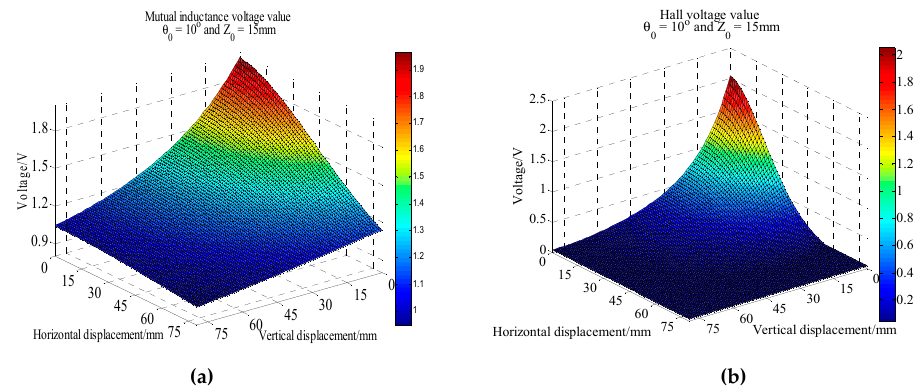
Figure 8. Voltage acquisition data at 0 ◦ inclination. ( a ) Mutual inductance voltage; ( b ) Hall voltage.